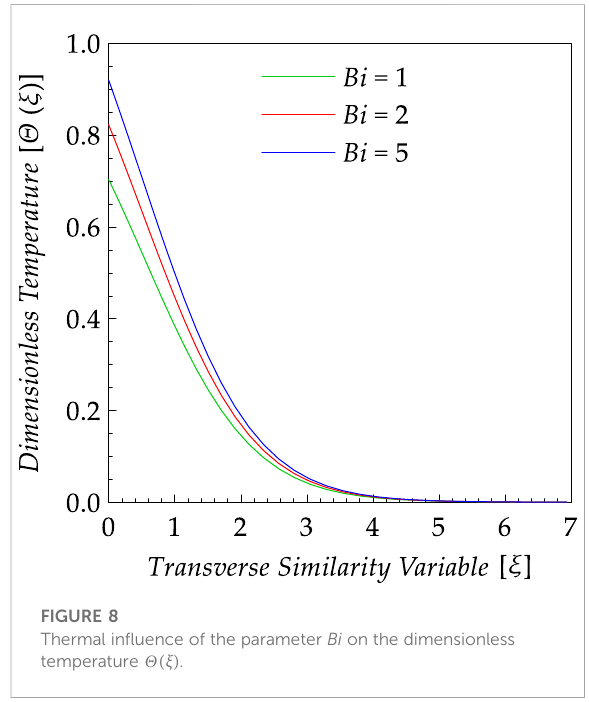
FIGURE 8 Thermal in fl uence of the parameter Bi on the dimensionless temperature Θ ( ξ ) .